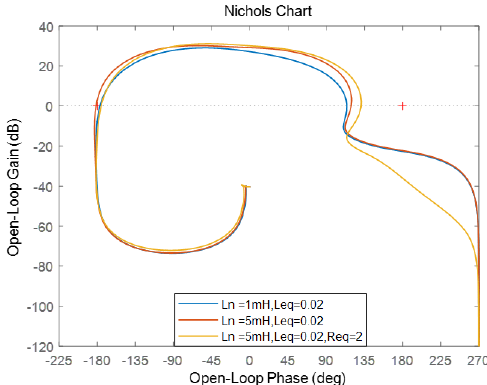
Figure 13. Nichols plots of T m under a different grid impedance.